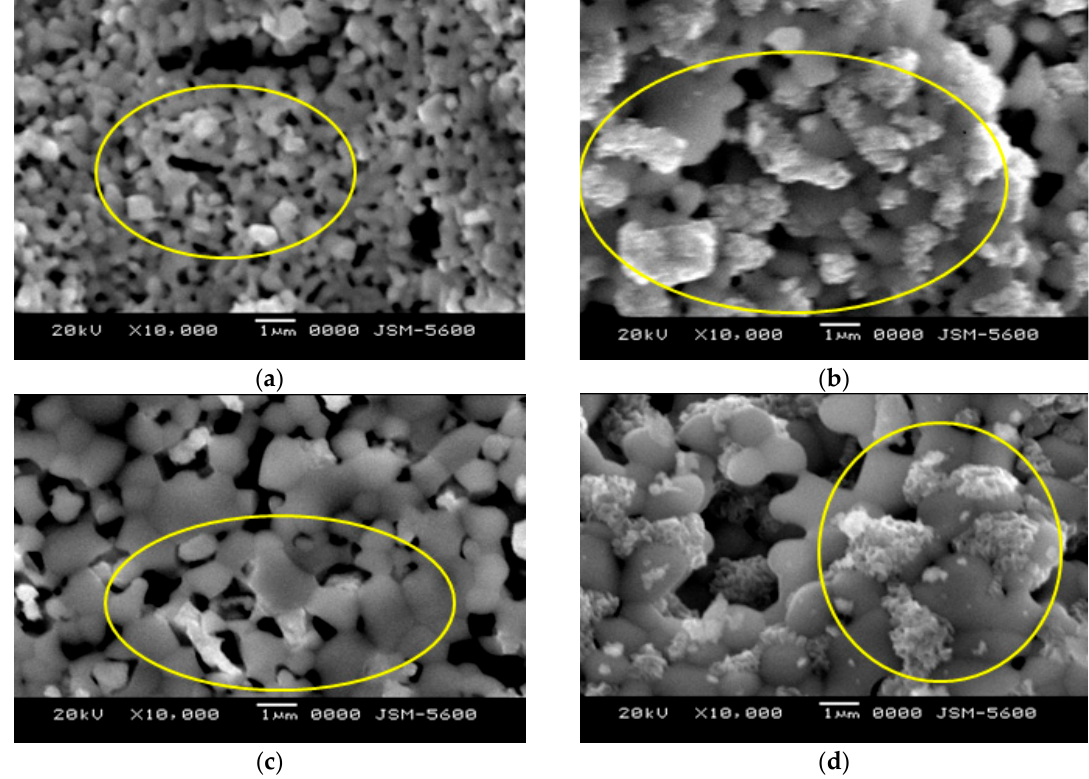
Figure 8. Series of SEM photographs of the anode-electrolyte samples with various sintering temperatures: ( a ) 1250 °C; ( b ) 1350 °C; ( c ) 1400 °C; and ( d ) 1450 °C.